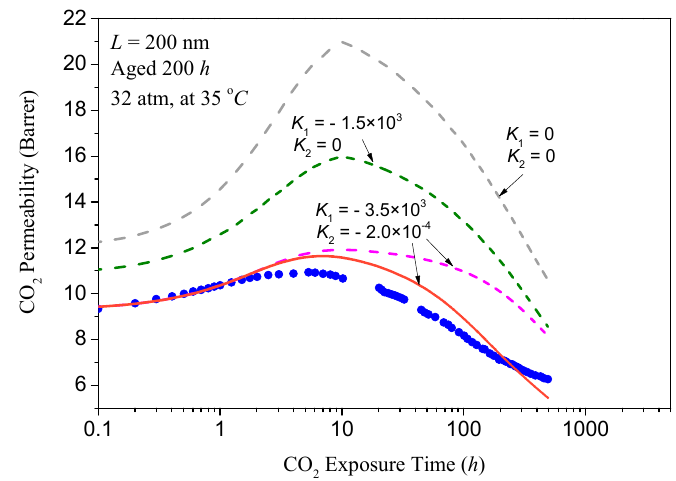
Figure 3. Comparison of the experimental data (symbols) [29] with the model predictions (lines): ( a ) Without CO 2 exposure; ( b ) with short-time CO 2 exposure.